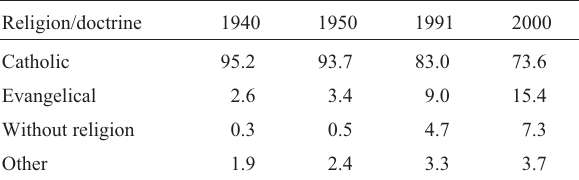
Table 1 - Distribution of the Brazilian population (%) among religions, between 1940 and 2000, according to the demographic census of the Instituto Brasileiro de Geografia e Estatística (IBGE